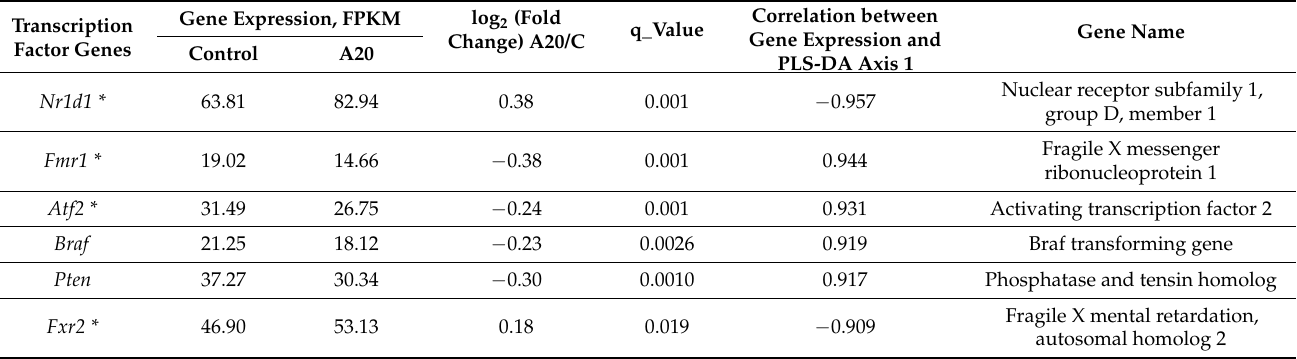
Table 3. DEGs associated with neurogenesis and making the largest contribution (r > |0.90|) to intergroup differences in